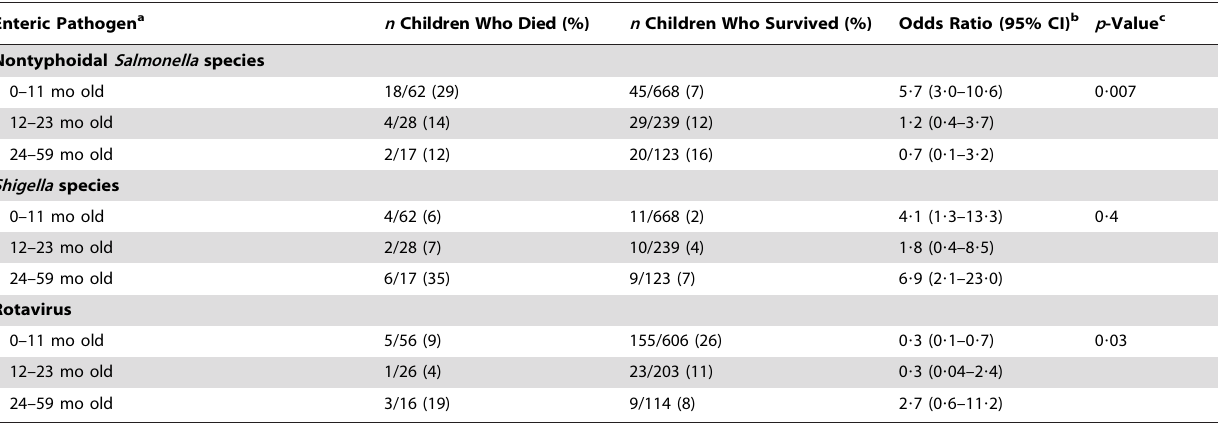
Table 3. Select enteric pathogens identified by age group among enrolled children , 5 y old hospitalized with diarrhea and had a stool specimen cultured and/or tested for viral pathogens, by children who died ( n =107) and survived ( n =1,039), western Kenya